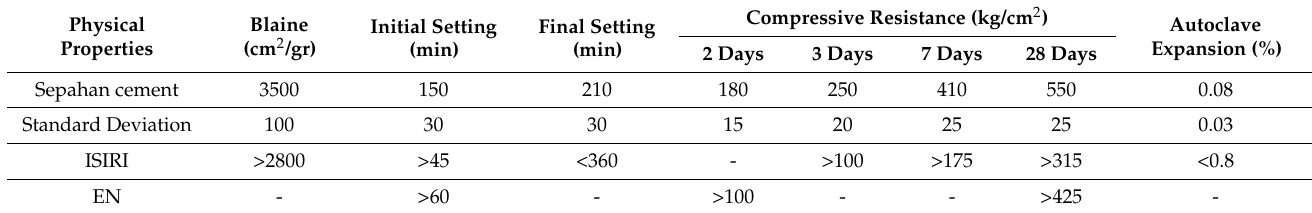
Table 4. Physical properties of Portland cement (Type